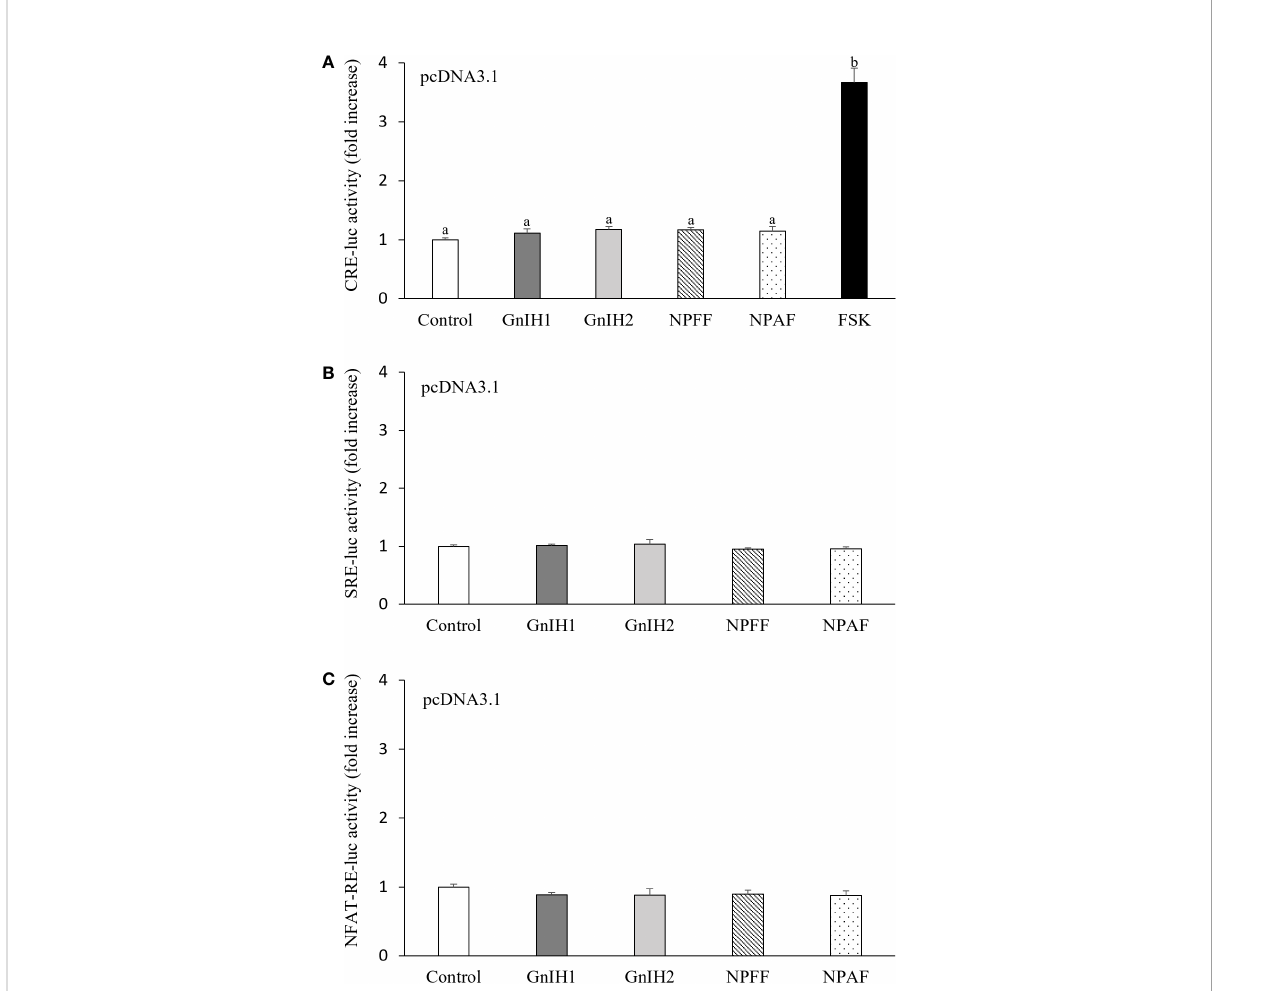
FIGURE 1 Effects of GnIH and NPFF peptides on CRE-luc (A) , SRE-luc (B) , and NFAT-RE-luc (C) activity in COS-7 cells transfected with the empty pcDNA3.1 vector. Cells were challenged with each peptide (1 m M) for 6 h and then harvested for assays. FSK (10 m M) acted as a positive control. Data are presented as the mean ± SEM (n = 6). Different letters indicate statistically signi fi cant differences between mean values (ANOVA one- way p <